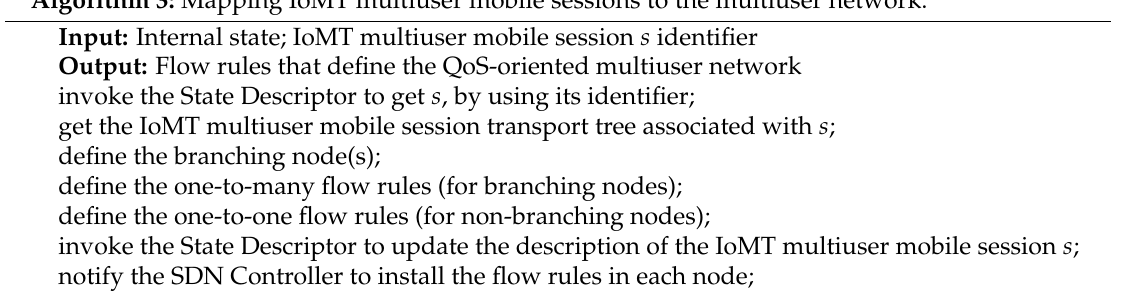
Algorithm 3: Mapping IoMT multiuser mobile sessions to the multiuser